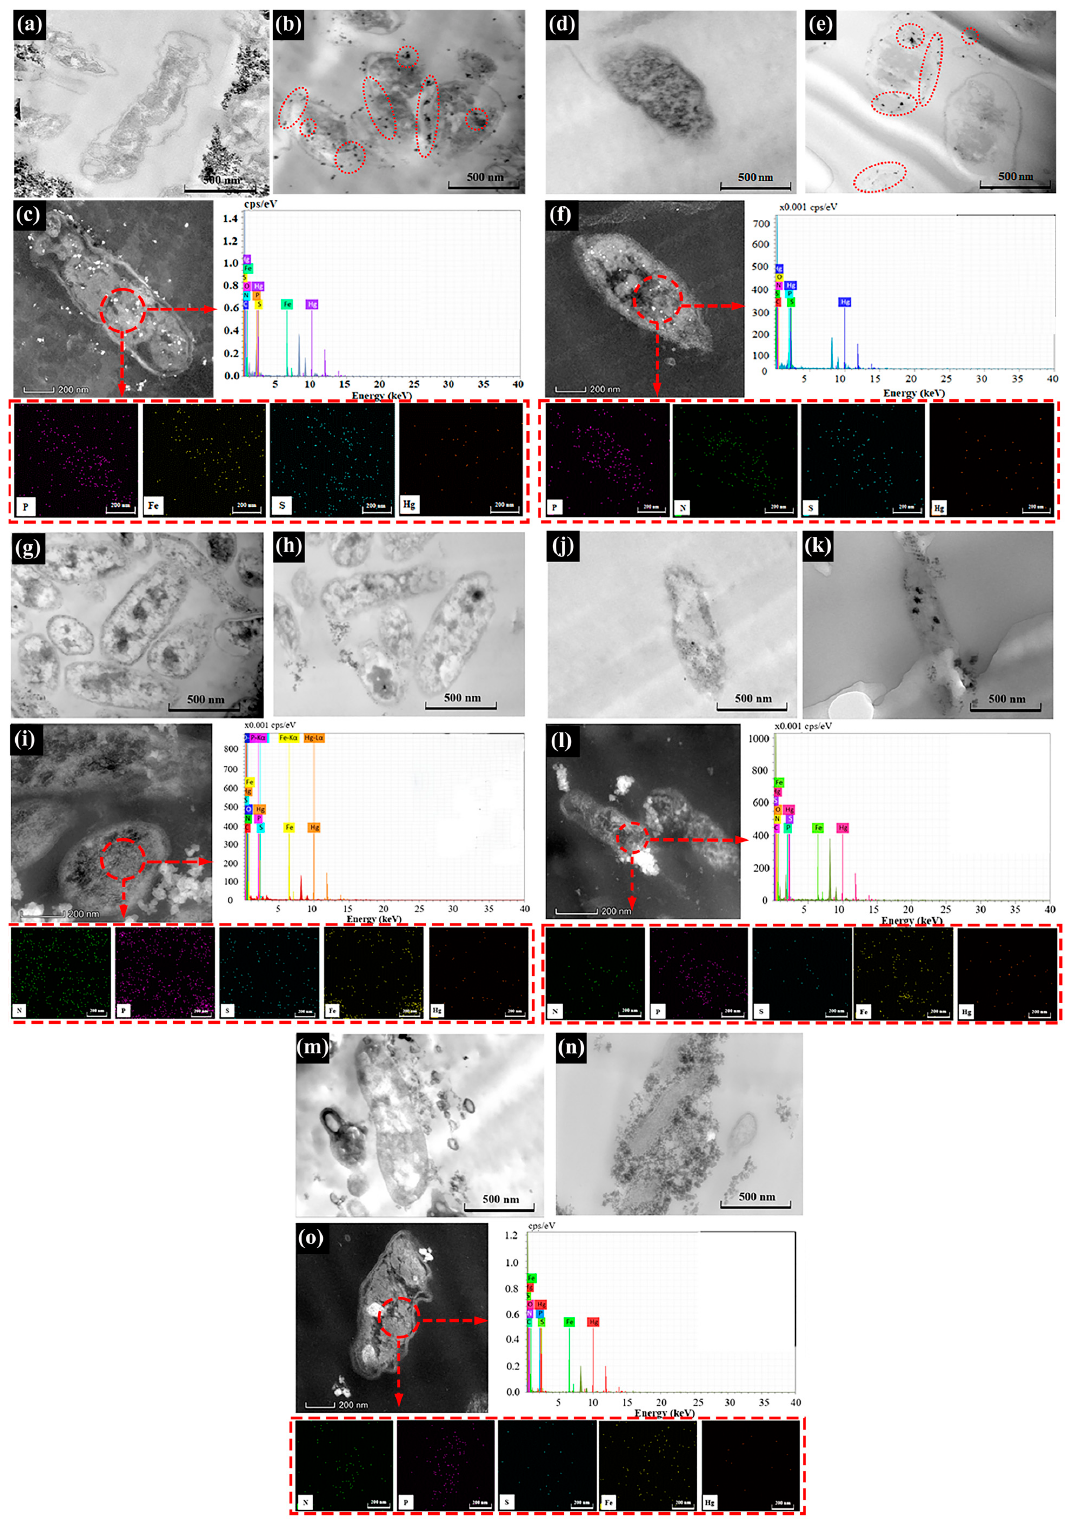
Figure 3. TEM images and TEM-EDS images of bacterial cells of A. ferrooxidans ATCC 23270 in the presence of Hg 2+ . ( a ) TEM images for the group with Fe 2+ oxidation with 0 mg/L [Hg 2+ ]; ( b ) TEM images for the group with Fe 2+ oxidation with 1 mg/L [Hg 2+ ]; ( c ) TEM-EDS images for the group with Fe 2+ oxidation with 1 mg/L [Hg 2+ ]; ( d ) TEM images for the group with S 0 oxidation with 0